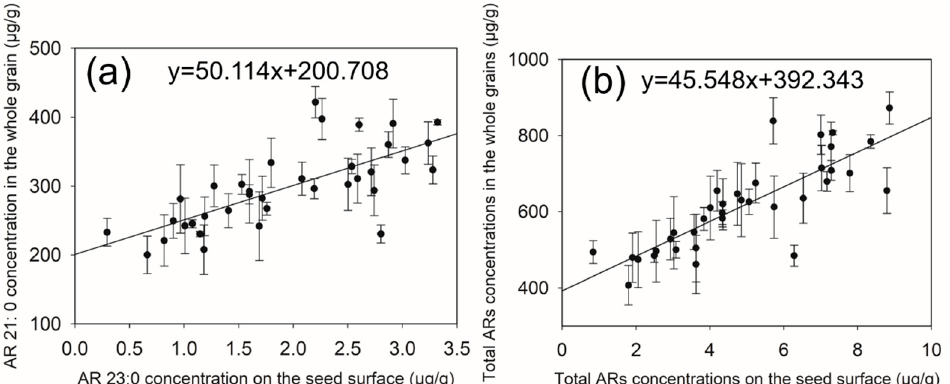
Figure 6. ( a ). Correlation between AR 23:0 concentration on seed surfaces and AR 21:0 concentration in whole grains. (R 2 = 0.524) ( b ). Correlation between total ARs concentration on seed surfaces and that in whole grains (R 2 = 0.683). R 2 , the coefficient of determination of the standard curve; in the graph, the linear equation of the standard curve is reported. Data points are expressed as the mean ± SD of three biological replicates (n = 36, p < 0.001).